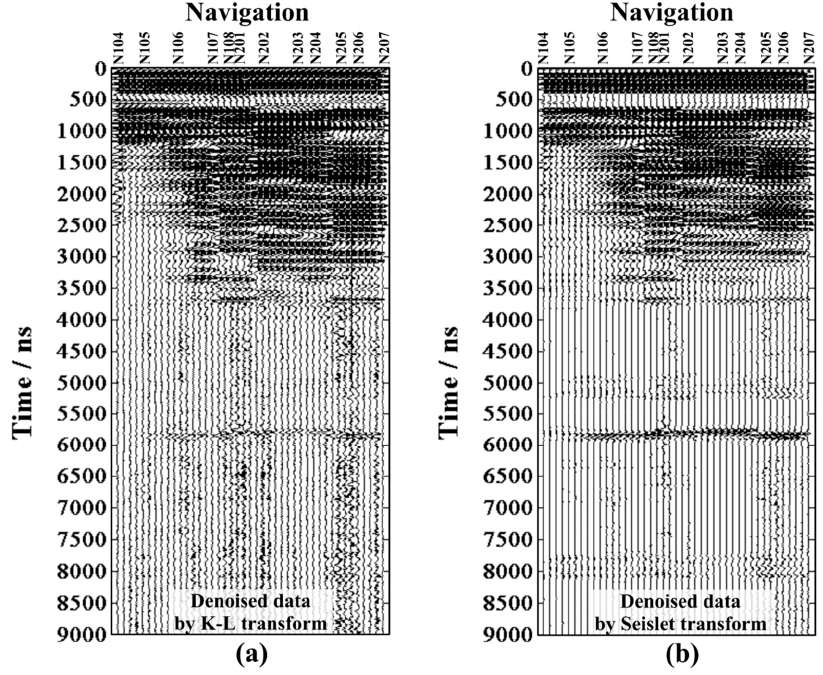
Figure 7. Demonstration of pre-denoised results. ( a ) K-L transform; ( b ) ST.